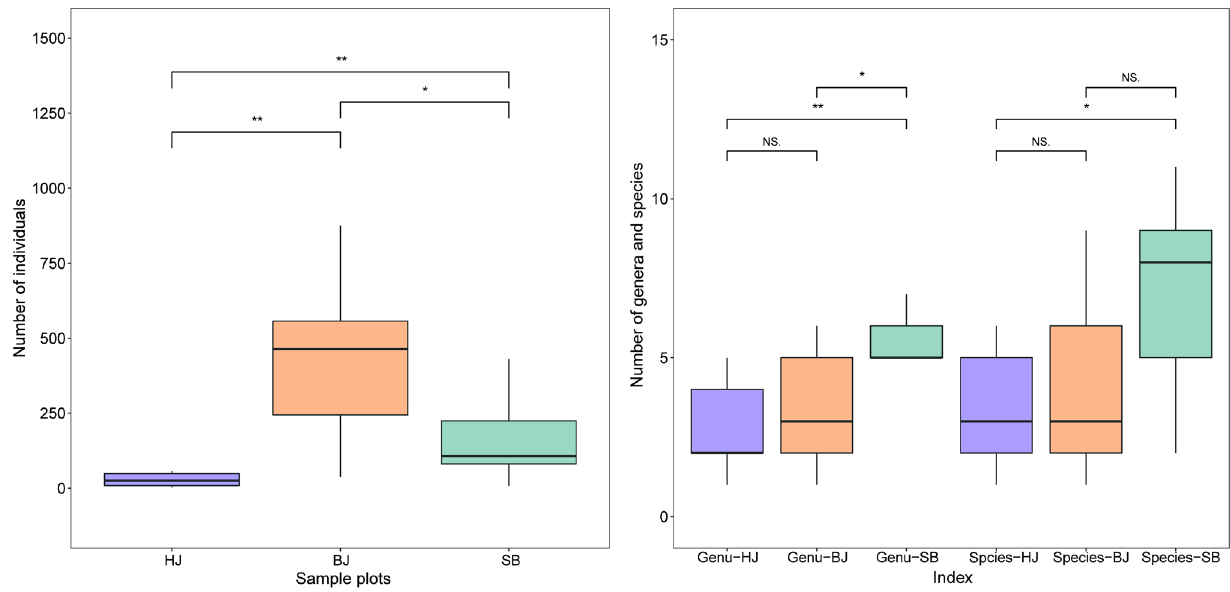
Figure 5. The number of individuals, geners, and species of Erythroneurine leafhoppers in different study areas and plots. (*, p < 0.05; **, p < 0.01). NS: No significant.